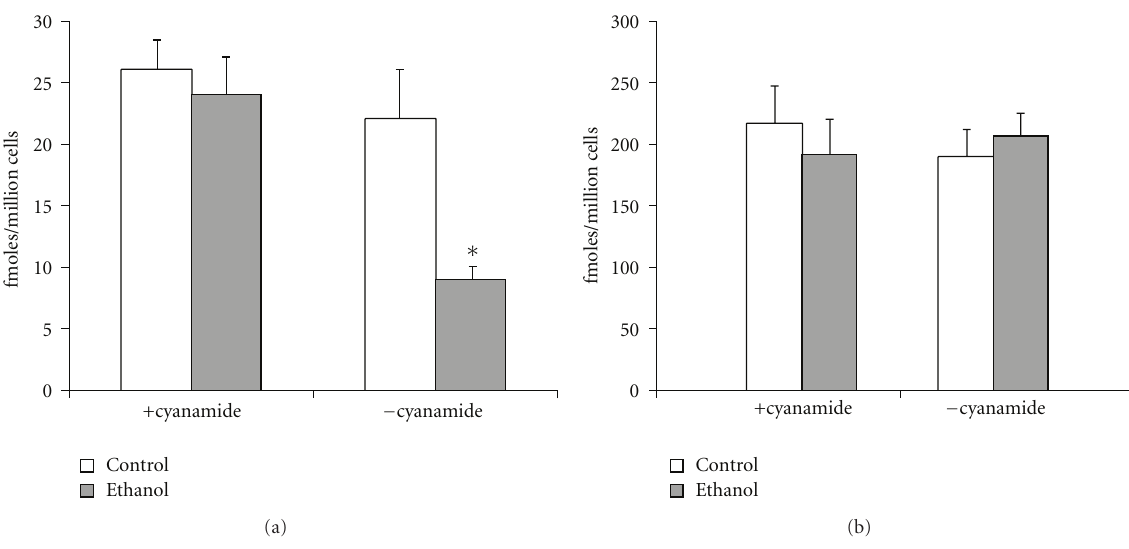
Figure 1: (a) E ff ects of ethanol (25mM) and cyanamide (0.1 mM) on binding of 125 I-ASOR to HAD cells treated for 7 days. HAD cells were grown to confluence and treated as described in Section 2. Ligand binding was performed at 4 ◦ C for 3 hours and non-specific binding was determined in the presence of 100-fold excess unlabeled ligand. Data are presented as means ± SEM for 6–10 sets of cells. Legends: control: HAD cells cultured in the absence of added ethanol; ethanol: HAD cells cultured in the presence of 25 mM ethanol. Values significantly di ff erent from controls are indicated, ∗ P < 0 . 05. (b) E ff ects of ethanol administration (25mM) and cyanamide (0.1mM) on binding of anti-ASGP-R antibody to HAD cells. Cell cultures were obtained from the same conditions as in Figure 1(a). Binding of antibody was determined by the ability of cells to bind a polyclonal antihuman ASGP-receptor antibody, followed by radiolabeled detection of 125 I-protein A. Data are presented as means ± SEM for 6–10 experiments. Legends: control: HAD cells cultured in the absence of added ethanol; ethanol: HAD cells cultured in the presence of 25 mM ethanol.